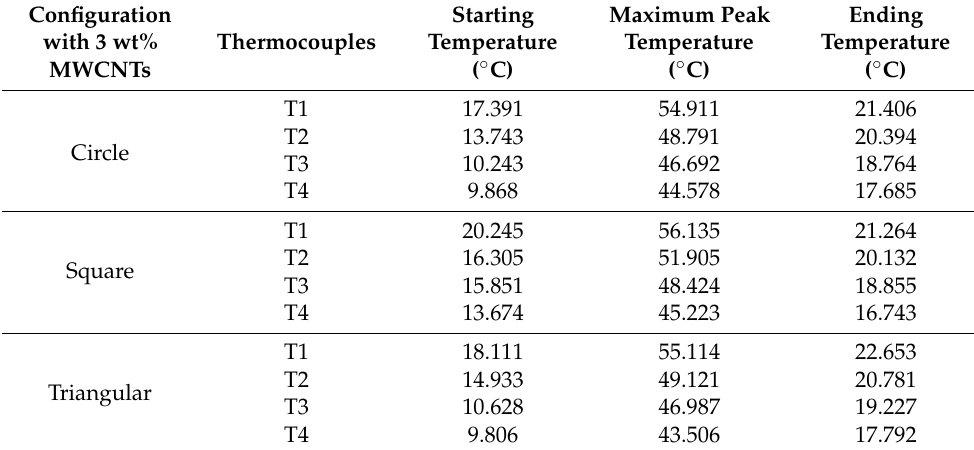
Table 5. Temperature data for configuration with 3 wt% MWCNTs.